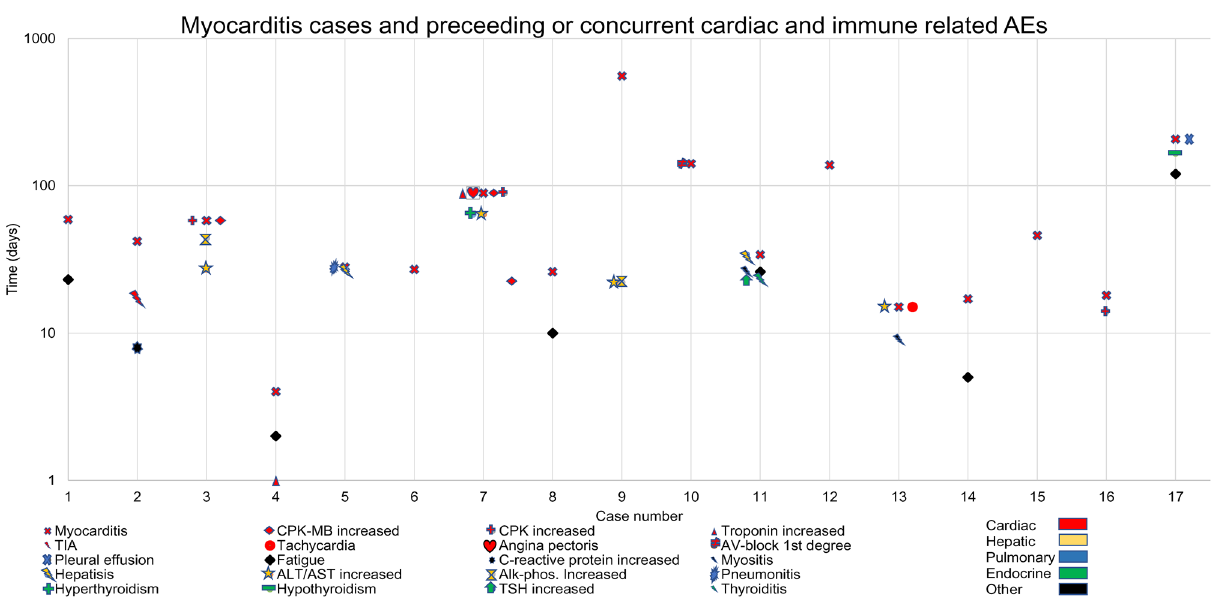
Figure 4. Progression of myocarditis cases with preceding AEs and AEs co-occurring at time of